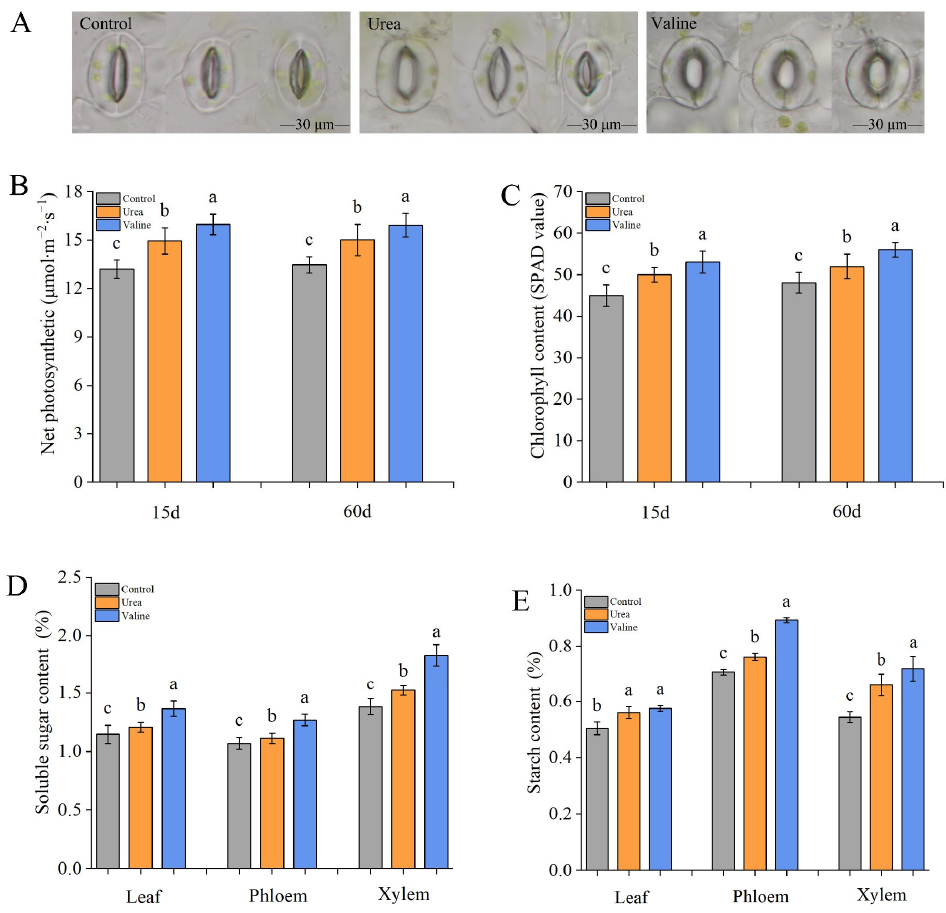
Figure 4. Effects of valine and urea on carbon metabolites in peach tree. ( A ) The shape and area of stomata. ( B ) Effects of different treatments on net photosynthetic rate of peach. ( C ) Chlorophyll content. ( D ) Soluble sugar content. ( E ) Starch content. Soluble sugar and starch contents were measured at day 60 after valine and urea treatment. The growth conditions, water status, and light conditions of the leaves used to collect stomata were the same. The error bar represents the standard deviation of the mean ( n = 3). Different lowercase letters indicate significant differences among treatments (Duncan test, p < 0.05).